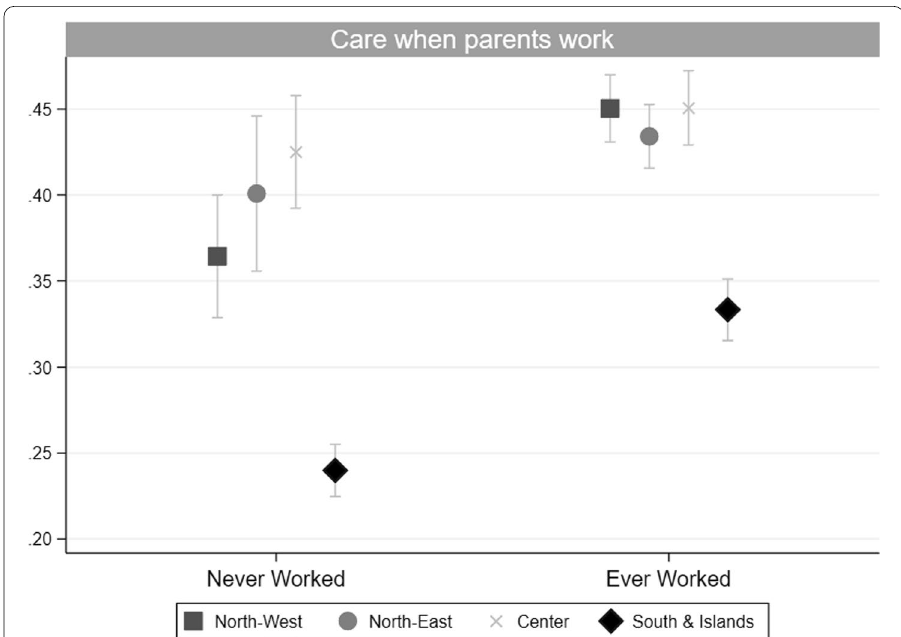
Fig. 6 Predicted probabilities ( y -axis) to perform grandparental childcare under different circumstances, by grandmothers’ work history (Having ever worked—no/yes) and macro-areas of residence. Results from logistic regression models, control variables included: age; occupational status; birth cohort; educational level. Interaction term added between work history (ever worked) and area of residence. CI for approximate 5% significance level for the comparison of pairs of predicted probabilities. Source : Authors’ elaborations on Multipurpose surveys on Families and Social Subjects—ISTAT, 2003, 2009, 2016. N =